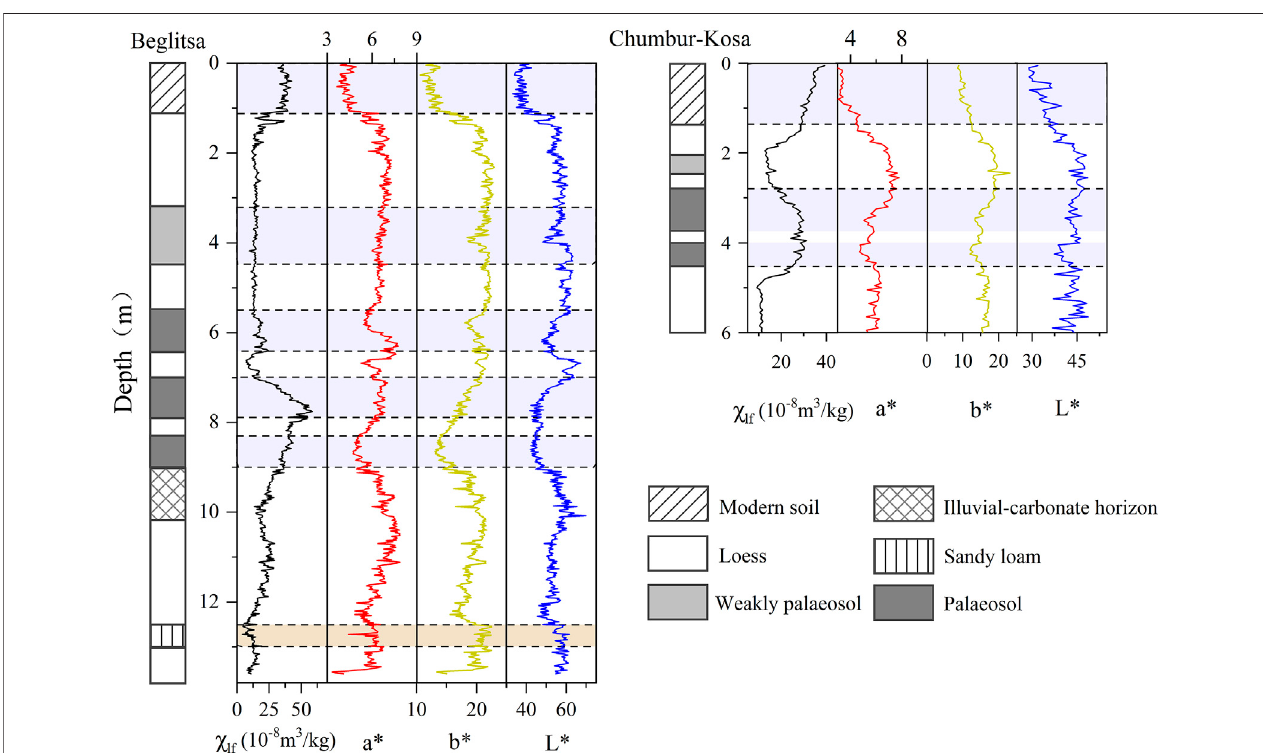
FIGURE 4 | Color index (L*, a*, b*) against the χ lf variations in the Beglitsa and Chumbur-Kosa sections.